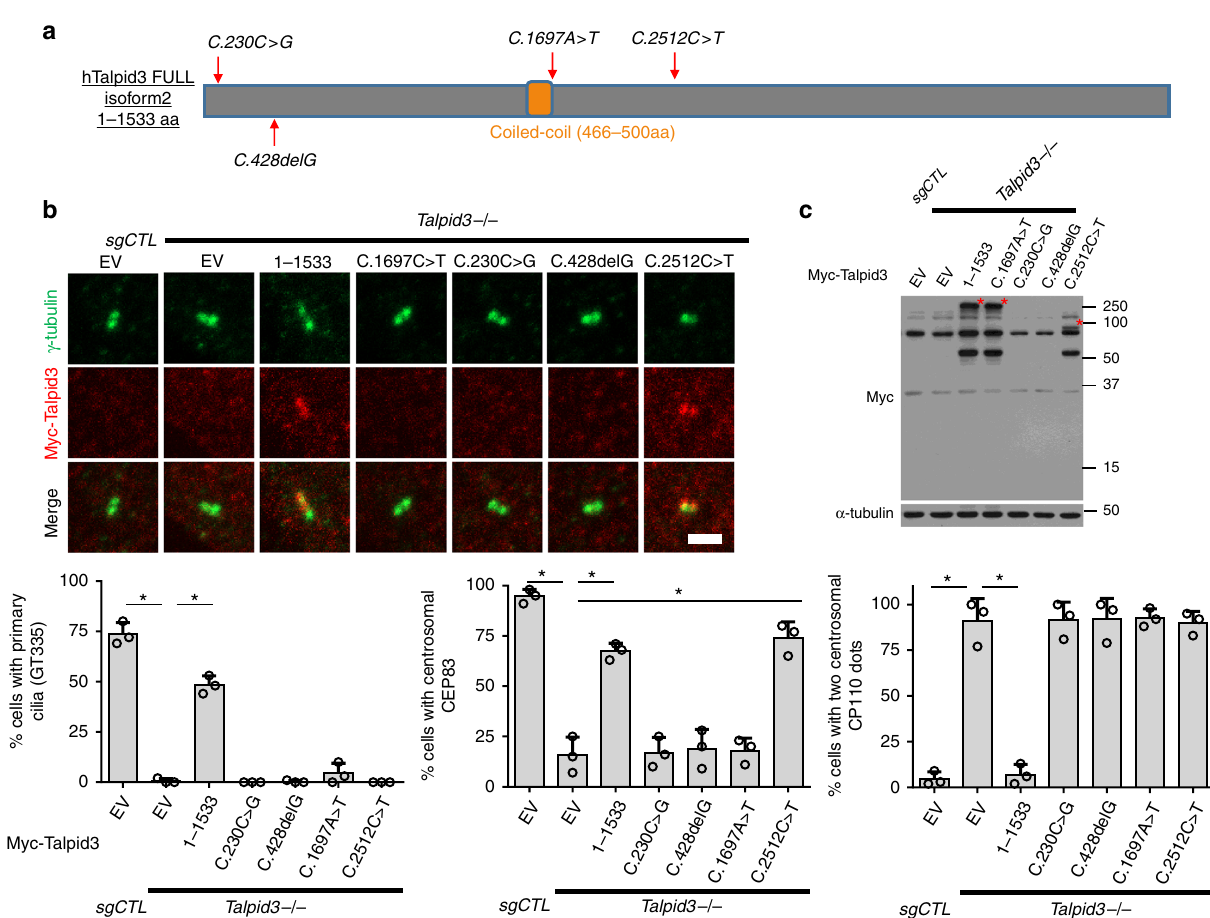
Fig. 8 Talpid3 mutants associated with JBTS and other lethal ciliopathies display centriole maturation defects. a Summary of Talpid3 mutations under investigation and their locations (red arrows) in Talpid3 protein. Centrosomal and ciliary defects in Talpid3 KO cells were rescued by infection with lentiviruses expressing Myc-tagged Talpid3 constructs. Cells were examined by IF ( b ) and WB ( c ) after 48 h of serum starvation using indicated antibodies. Speci fi c truncation proteins are indicated with an asterisk. Cumulative data from three independent experiments are shown. For each group, a minimum of 100 cells/experiment was averaged. All data are presented as mean ± SD. * p < 0.05 (unpaired t -test). Scale bar = 2 μ